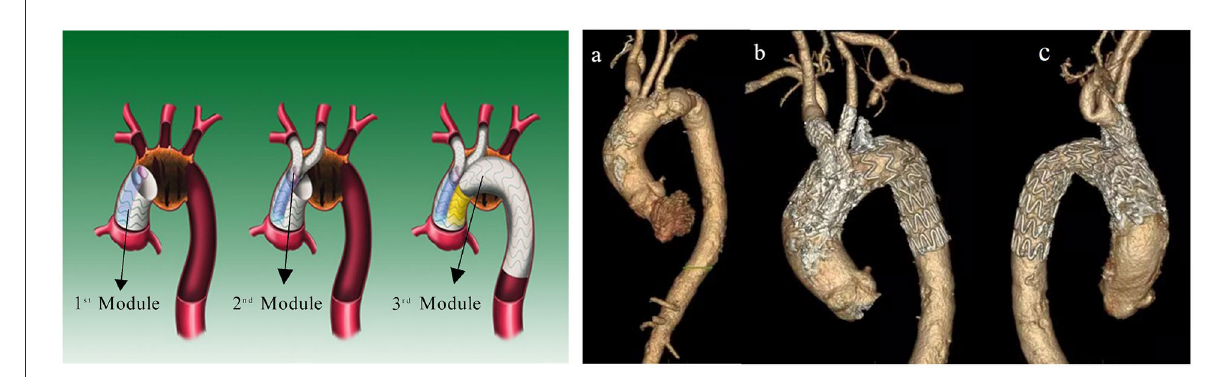
FIGURE1 (Left) Diagram and (right) in vivo morphology of MIBSG. First module: main body stent-graft with double embedded tunnels landing in ascending aorta. Second module: two inner bridging stent-grafts to the supra-arch vessels. Third module: distal extending stent-graft in the descending aorta. (a) Preoperative morphology of aneurysm. (b,c) Postoperative morphology of MIBSG. MIBSG = modular inner branched